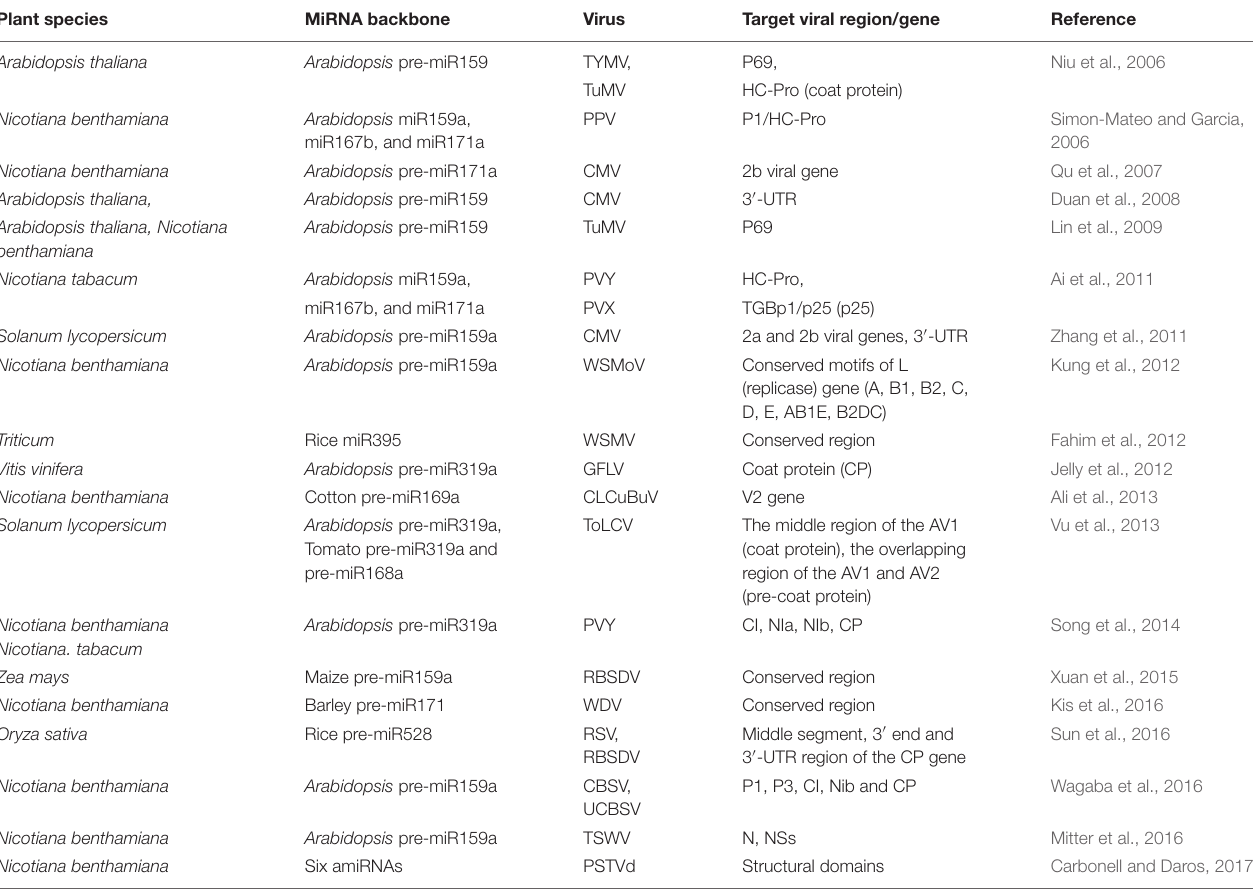
TABLE 1 | Engineering of plant miRNA for antiviral